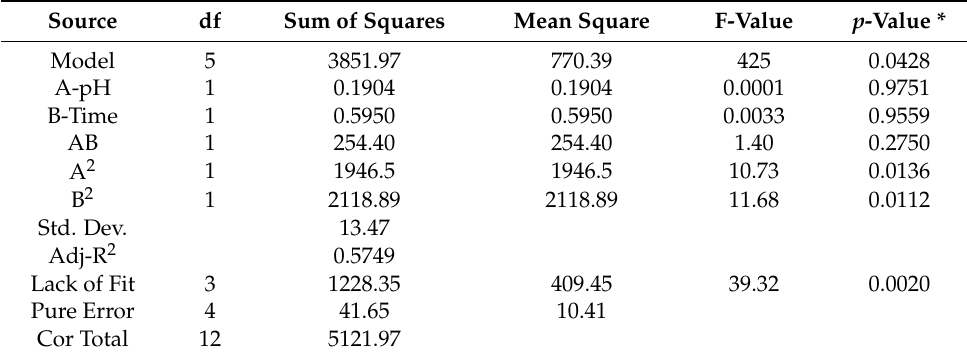
Table 3. ANOVA results for the response surface quadratic model (MPR max ). Source df Sum of Squares Mean Square F-Value p -Value *